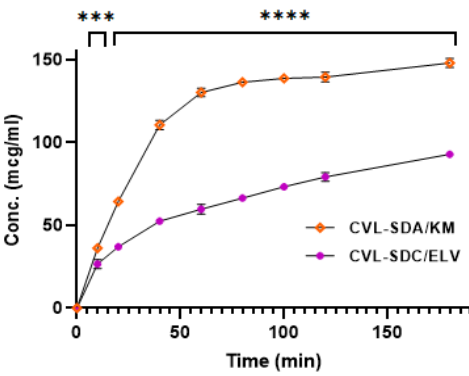
Figure 7. Solution phase transfer profiles of CVL-SDA/KM and CVL-SDC/ELV (data expressed as mean ± SD, n = 3; ns—non-significant, * p < 0.05, ** p < 0.01, *** p < 0.001, **** p <